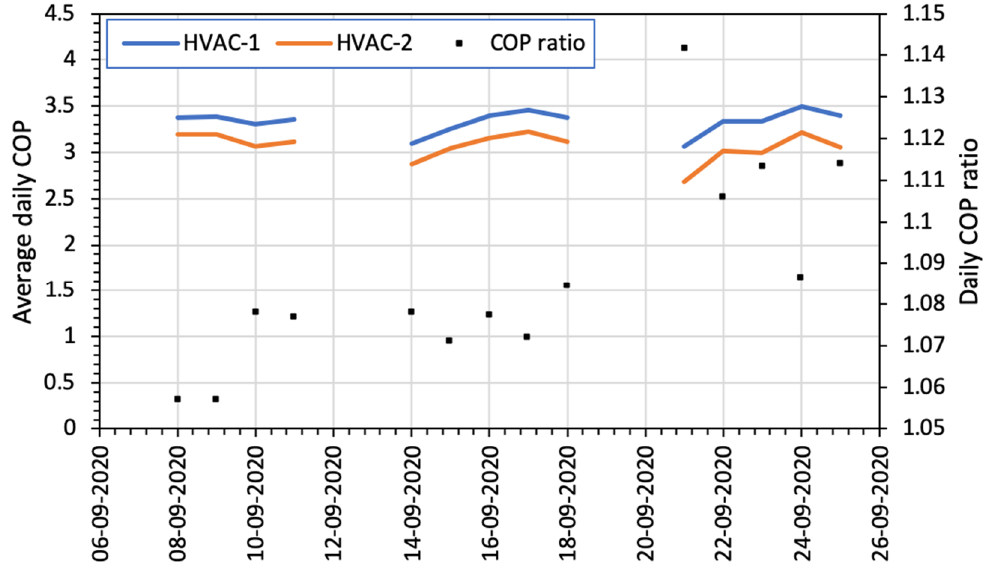
Figure 7. Hourly COP comparison between HVAC-1 and HVAC-2 (7 September 2020–25 September 2020).